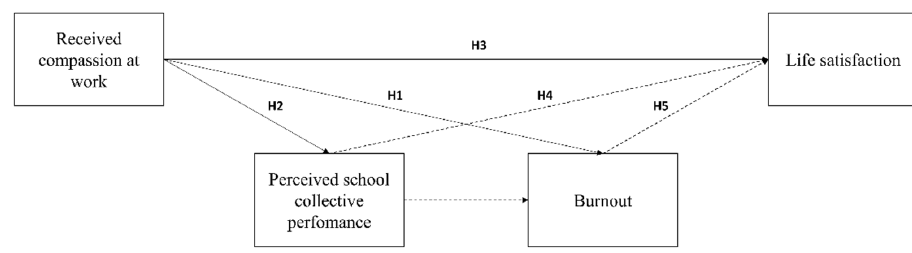
Figure 1. Theoretical model and